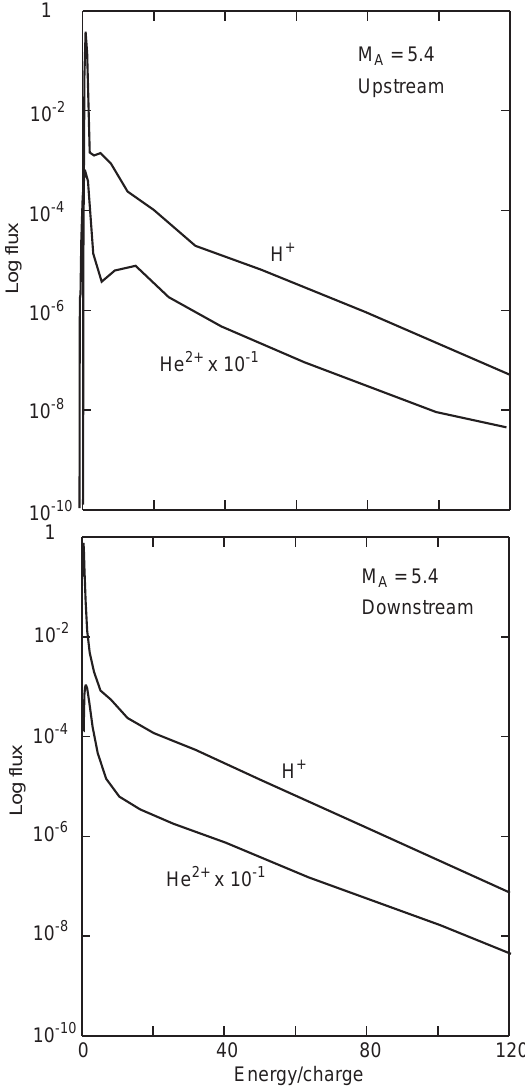
Fig. 8. The flux distributions of protons and alpha particles upstream ( a ) and downstream ( b ) of the M A (cid:136) 5 : 4 shock at X cp t